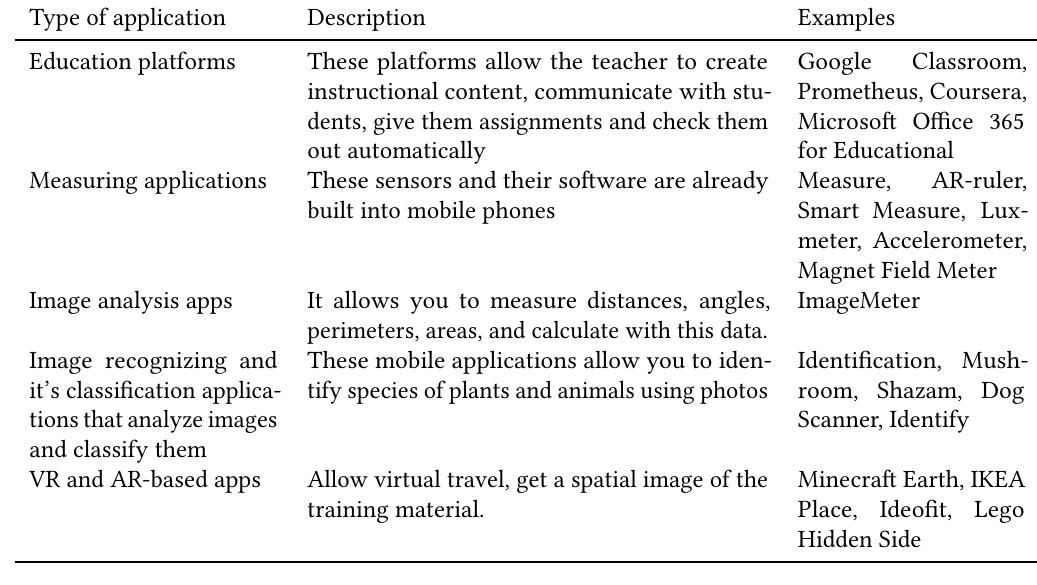
Comparison of the most used in the education process